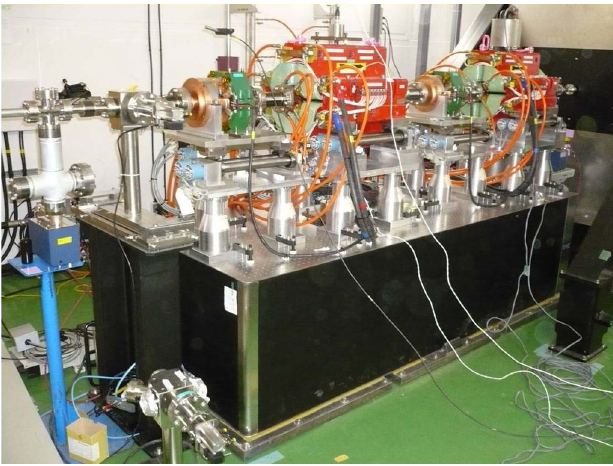
FIG. 4. (Color) View of the final doublet installed on its rigid mechanical support system.